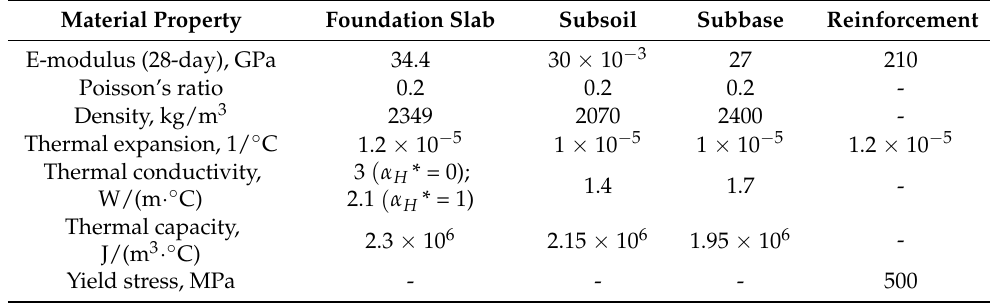
Table 1. Basic material data [29,30,32–34,42].